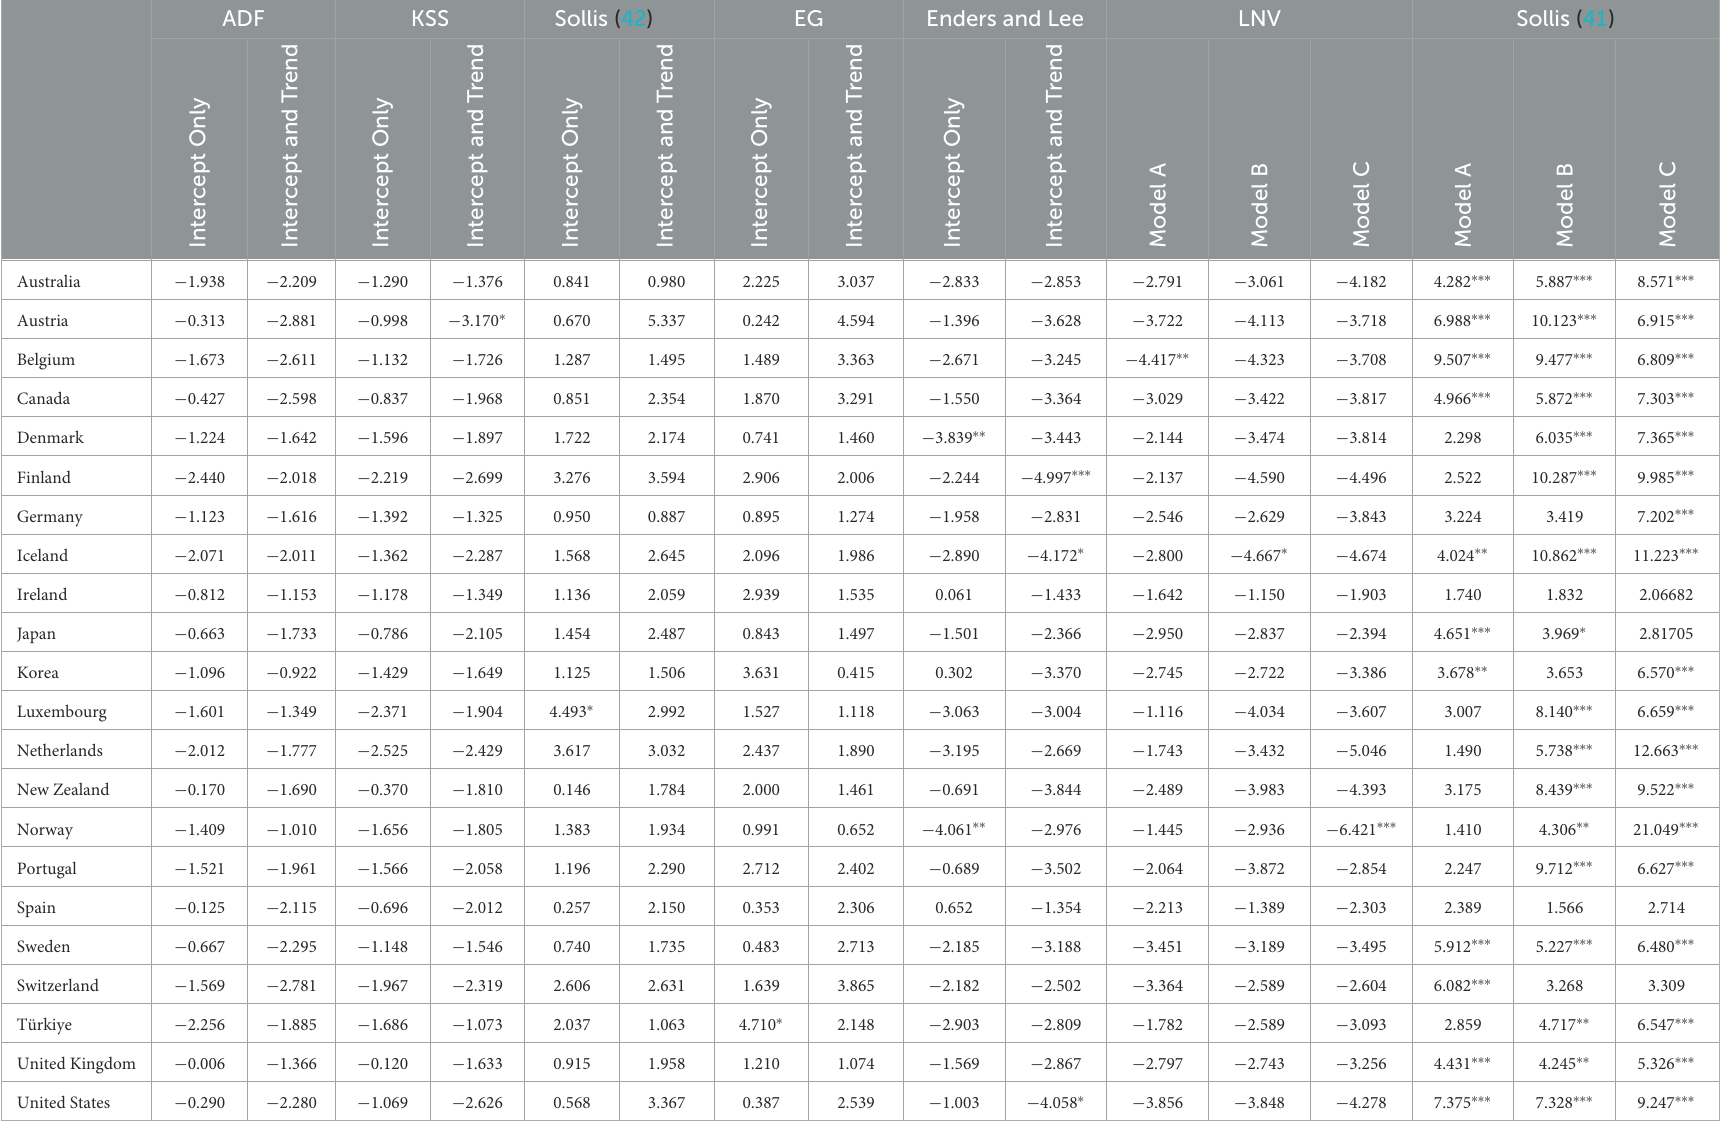
TABLE 2 Results of time series unit root tests–output per qualified